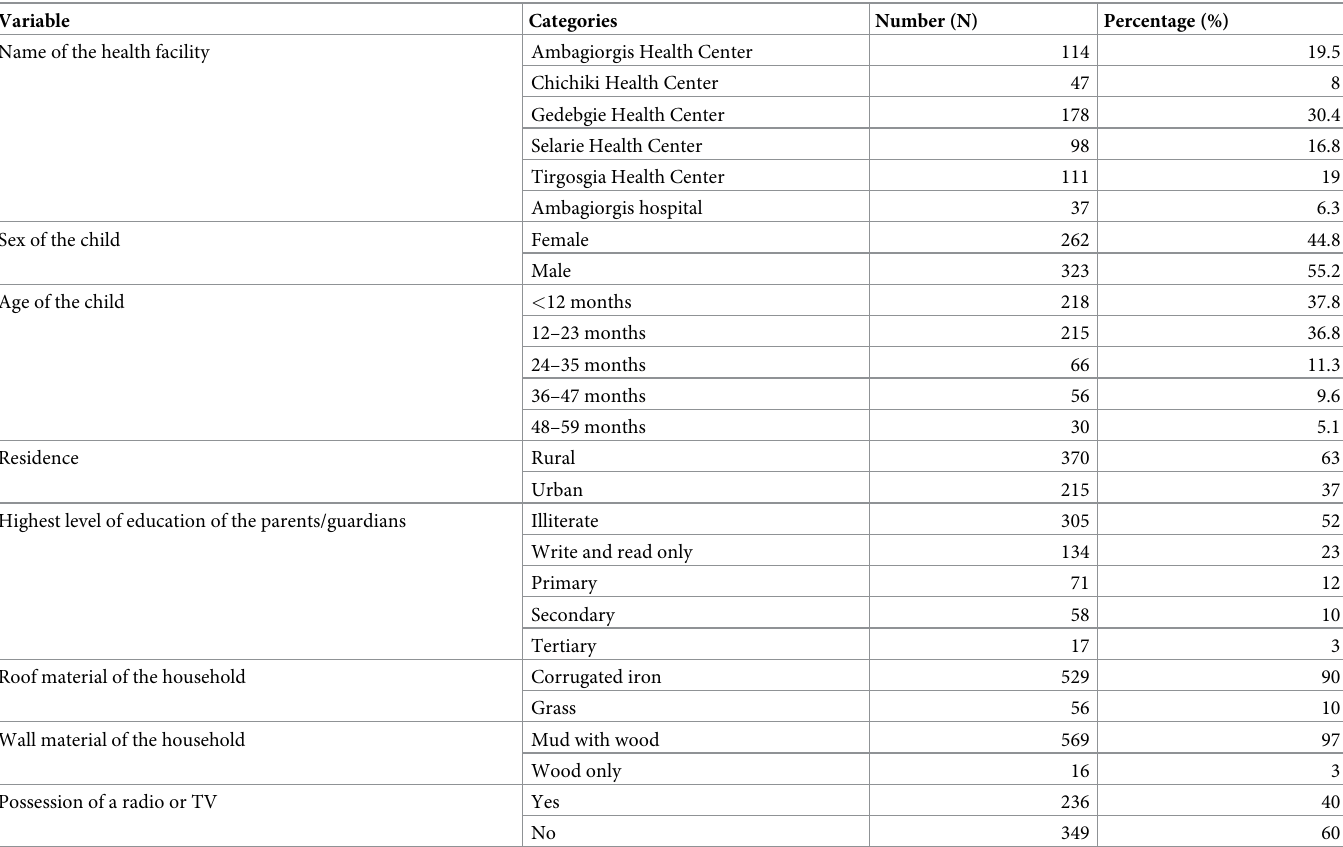
Table 1. Socio-demographic characteristics of study participants, Wogera district, northwest Ethiopia,